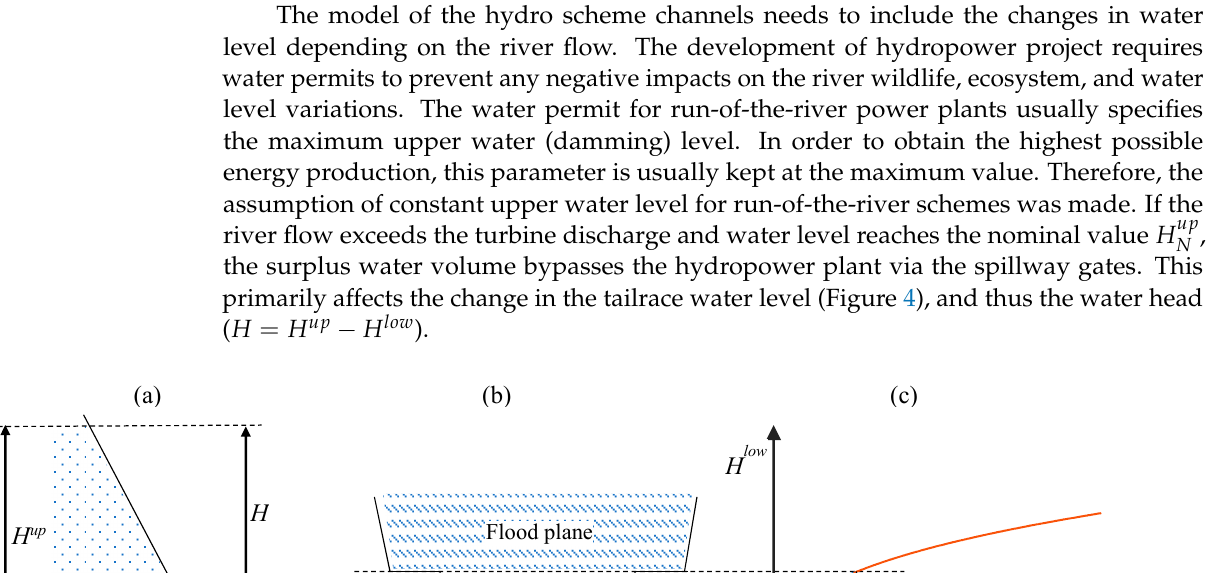
Figure 3. Structure of MLP neural network estimator of water turbine efficiency ( W —weights, b —biases).